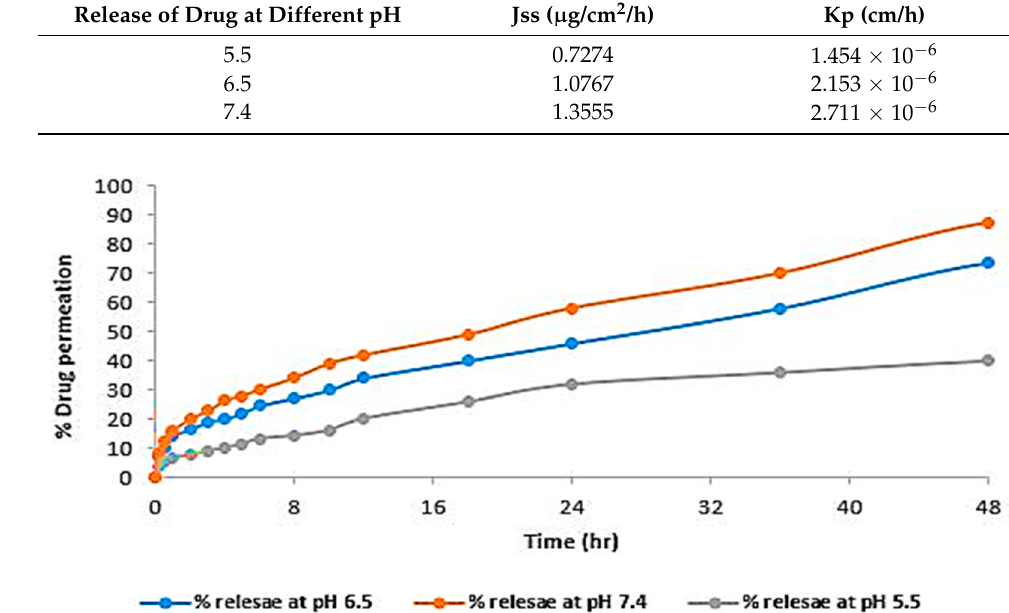
Table 5. Kinetic modeling on bacitracin zinc-loaded topical